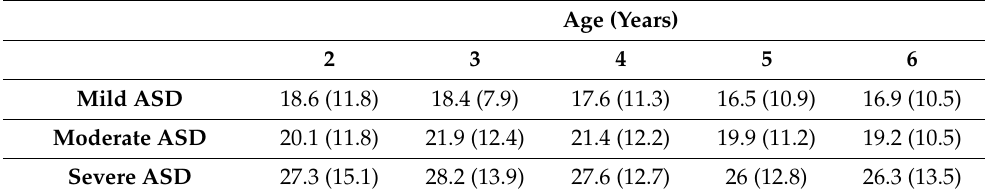
Table 6. Averaged Health (assessed by ATEC subscale 4) score for the mild, moderate, and severe ASD groups. A lower score indicates symptom improvement. The data are presented as the mean (SD).